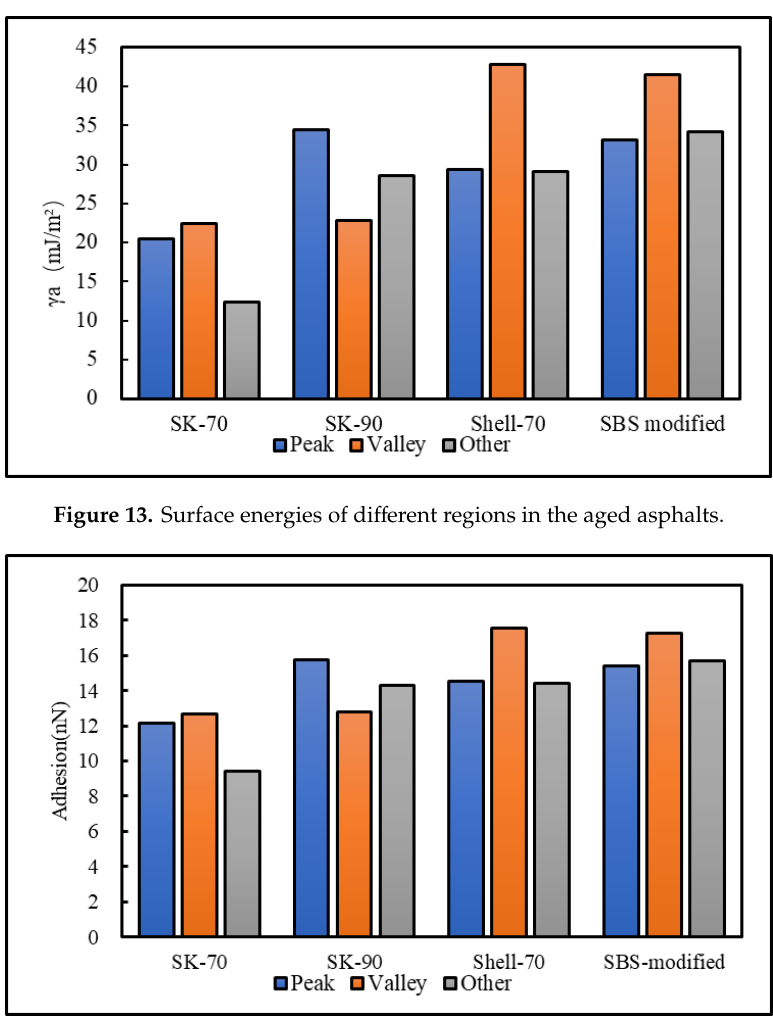
Figure 14. Adhesion between the probe and the aged asphalt in di ff erent regions. Table 5. The overall surface energy of di ff erent asphalts before and after